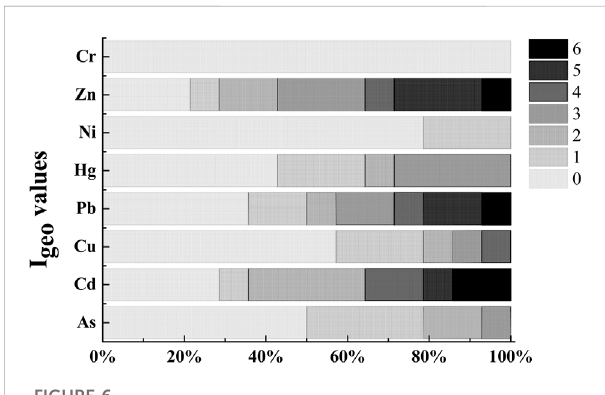
FIGURE 6 Class distributions of the geo-accumulation index for heavy metals.